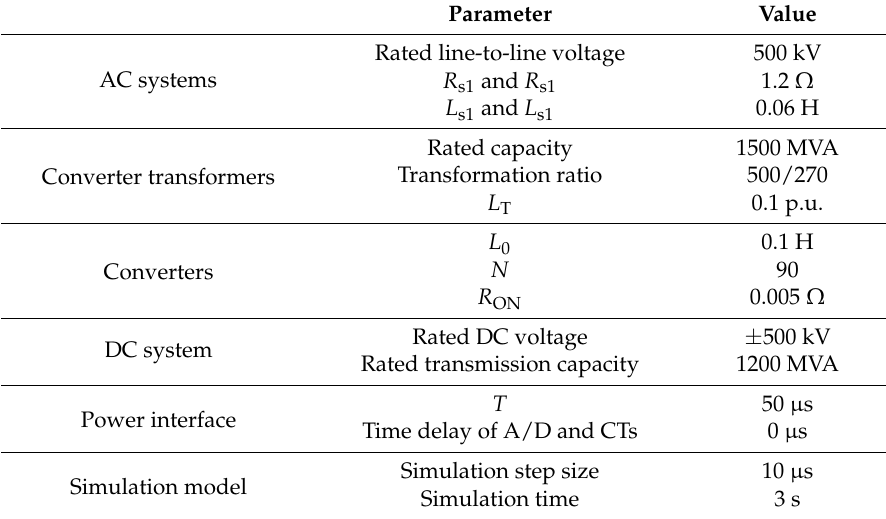
Table 1. Elements parameter values and simulation model settings.